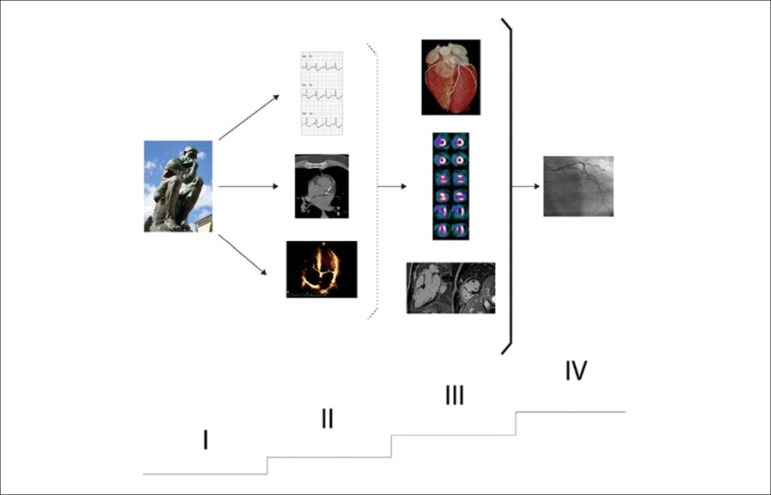
Concept of a rational strategy for evaluating and integrating modalities in a logical sequence of investigation of stable patients. It begins with the best rationalization for formulating diagnostic hypotheses (I), going on to the most basic tests (II), such as ECG/ET, ECHO, CS, continuing, as necessary, to more advanced non-invasive imaging methods (III), such as angio-CT, MPS, and CMR. The non-invasive tests, whether basic or advanced, should serve as “filters” for invasive testing, i.e. cardiac catheterization (IV), which should serve in planning advanced treatment only in patients under consideration for myocardial revascularization.234